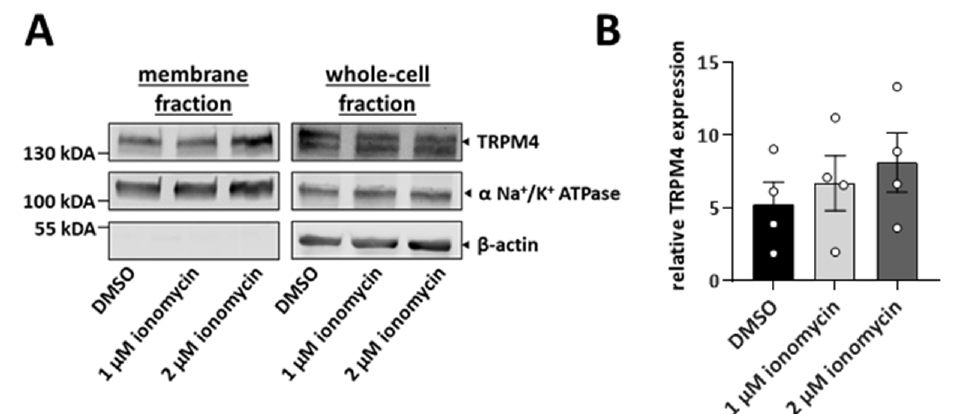
Figure 3. Increase in TRPM4 in the plasma membrane after stimulation with ionomycin. ( A ) HCT116 cells were stimulated with 1 or 2 µ M ionomycin for 15 min, and TRPM4 membrane expression was analyzed using a biotinylation assay. DMSO was used as a control. TRPM4 expression in membrane and whole-cell fractions. For the membrane fraction, α -Na + /K + -ATPase was used as a loading control, and β -actin was used as a negative control. For the whole-cell fraction, β -actin was used as a loading control. ( B ) Scatter plot and bar diagram of the quantification of the TRPM4 plasma membrane expression levels, shown as mean + SD. Experiment was repeated four times.